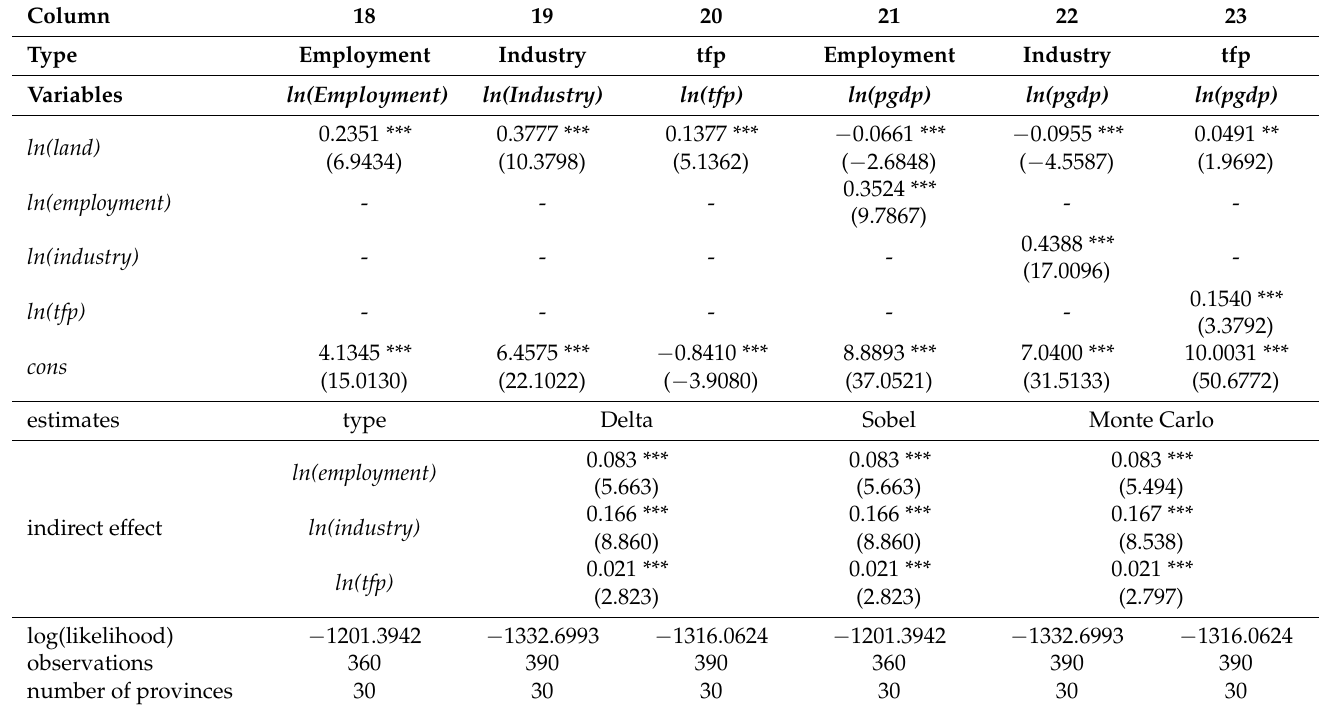
Table 6. Classification criterion of economic development stages by Chenery.